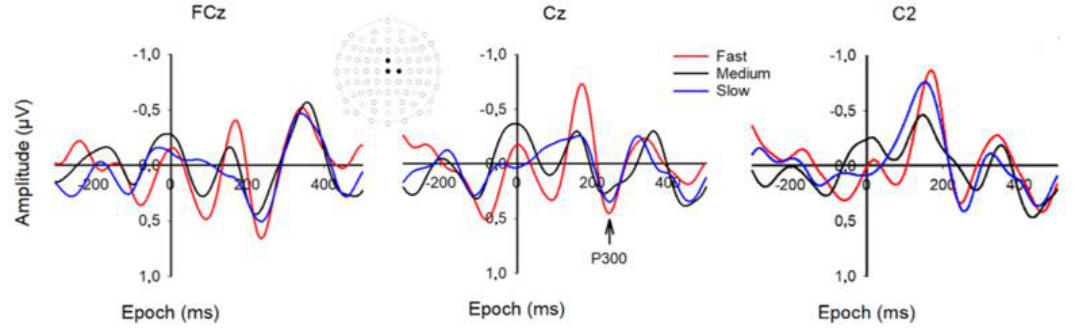
Figure 6. Grand-averaged waveforms of the MRP’s. Epoch is from − 300 to 500 ms. The head drawing (nose up) shows scalp locations of the 81 standard channels with the frontocentral channels of interest depicted with filled black circles (from top to bottom and left to right): FCz, Cz, C2. The arrow shows the P3 component of the three speeds at approximately 295 ms.